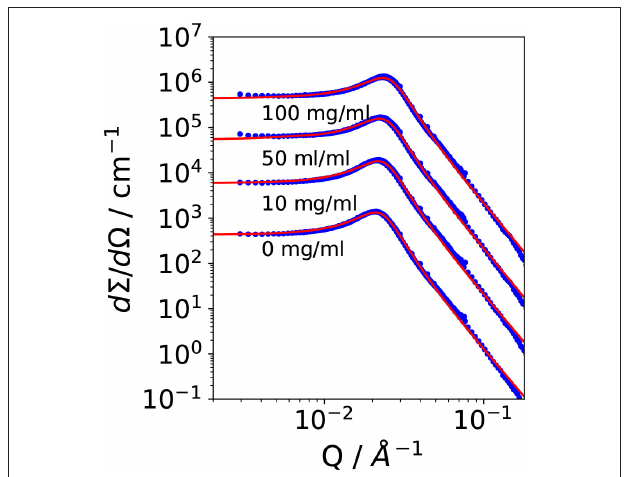
FIGURE 2 | Small angle scattering data of the bicontinuous microemulsions from the ternary system H 2 O/NaCl– n -octane–pentaethylene glycol monodecylether (C 10 E 5 ) with different amounts of lipase Candida antarctica B (CalB). The data were shifted by a factor of 10 for better